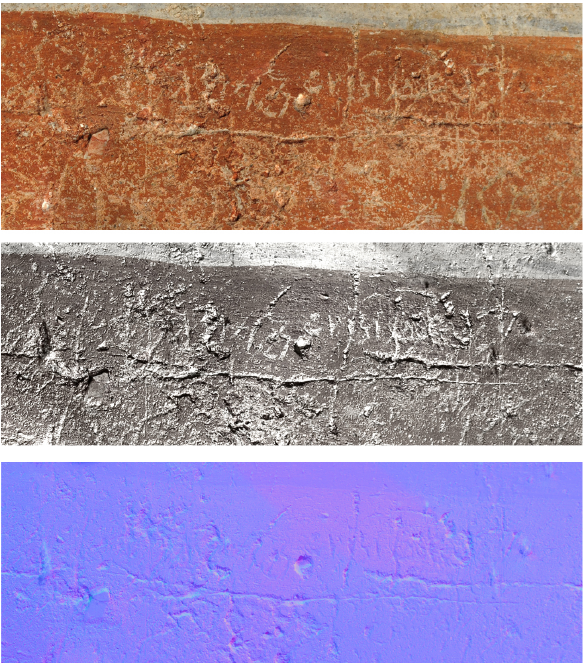
Figure 6. RTI outputs: Default mode (above); Specular Enhancement (middle); Normals Visualization (below)